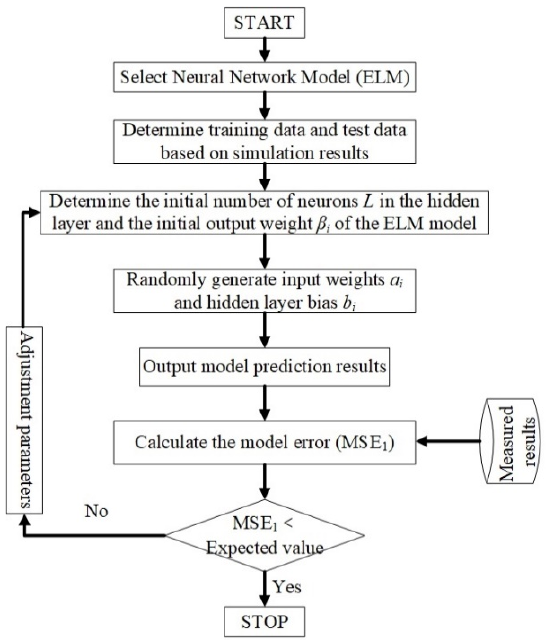
Figure 3. ELM (extreme learning machine)-based modeling flow for RF amplifier temperature characteristics.